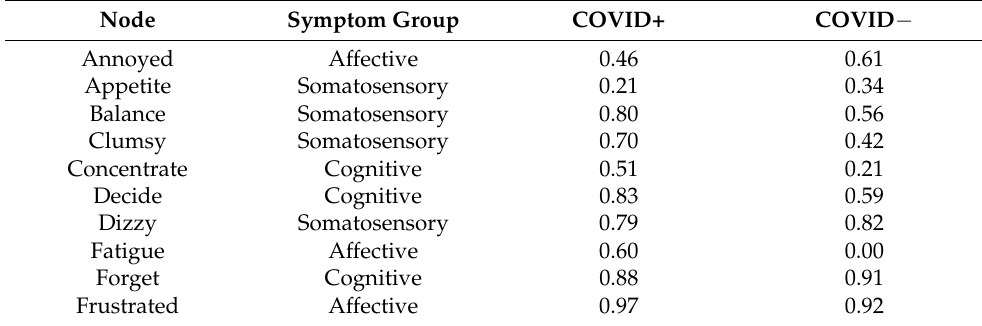
Table 2. Strength Centrality Estimates from Both